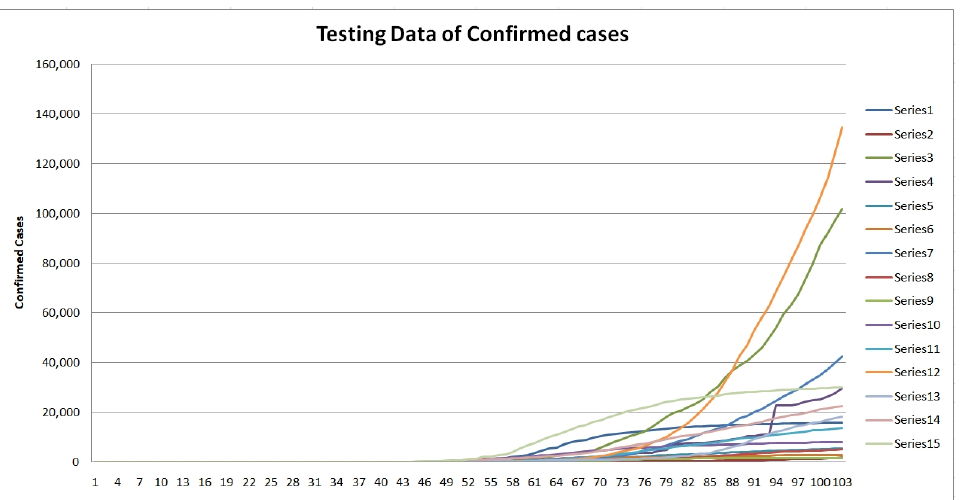
Figure 10. Nonlinear surface definitions for the classes by the fuzzy fractal model.